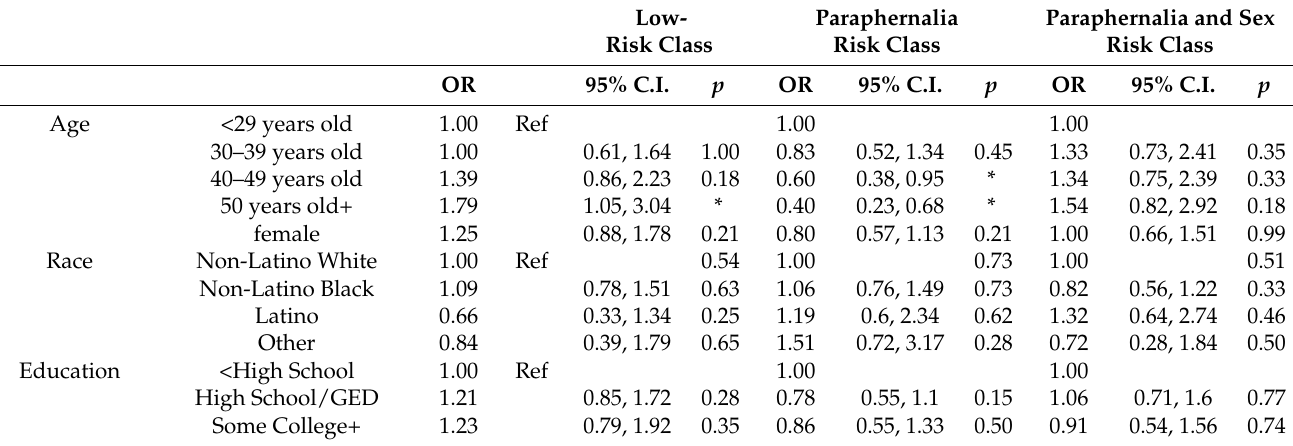
Table 4. Logistic regression analysis of selected demographic variables on latent class membership. ( n =